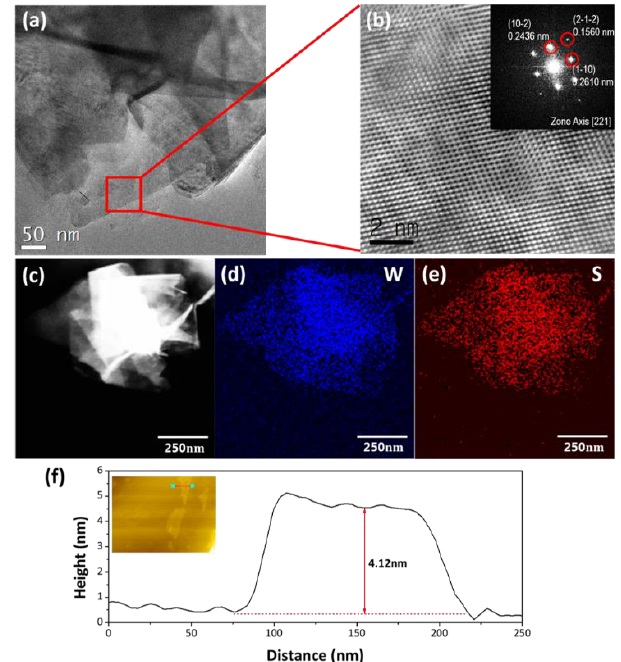
Figure 4. ( a ) Low-magnification TEM image of WS 2 nanosheets at 550 °C, ( b ) high-resolution TEM image and the fast Fourier transform (FFT) pattern of WS 2 nanosheets(inset) at 550 °C, ( c – e ) EDS elemental mapping analysis of W and S atoms in WS 2 nanosheets, ( f ) the height profile of WS 2 nanosheets grown at 550 °C by atomic force microscopy (AFM) line scan.